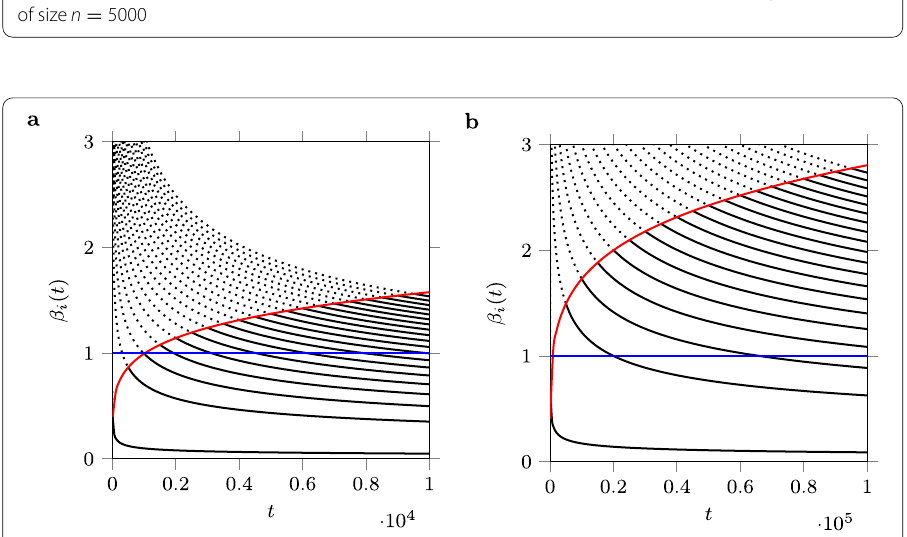
Fig. 16 Trajectories of β i ( t ) over t for nodes a i = 10,500,1000,1500, ... ,9000,9500 , the size of network n = 10 4 , b i = 100,5000,10000,15000, ... ,90000,95000 , the size of network n = 10